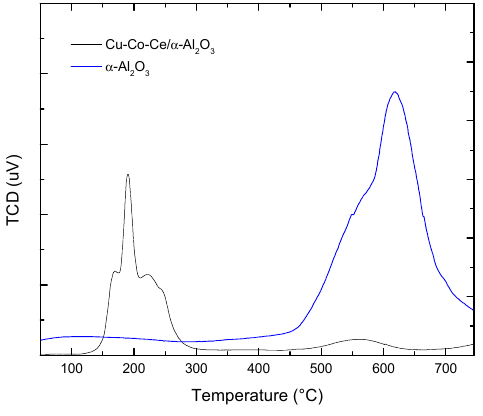
Figure 3. TPR of α -Al 2 O 3 support and catalyst Ce-Cu-Co/ α -alumina.